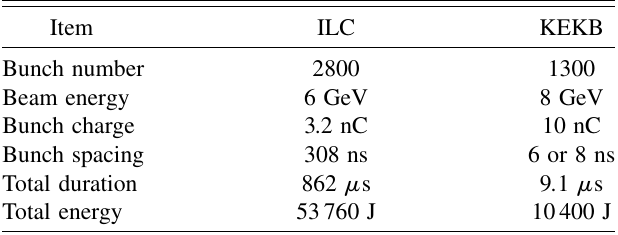
TABLE I. Characters of the ILC positron driver beam and KEKB HER stored beam.